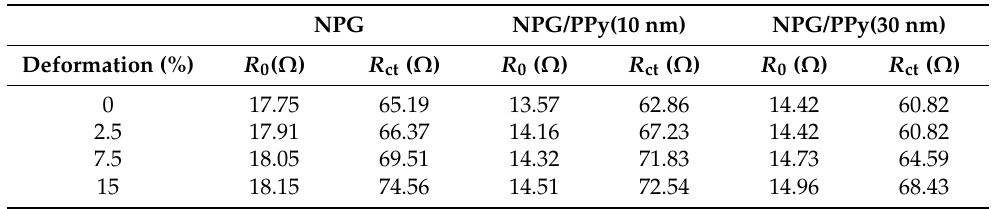
Table 2. Fitting parameters of bare NPG, NPG/PPy(10 nm), and NPG/PPy(30 nm) under various deformations based on the equivalent circuit in Figure S8.